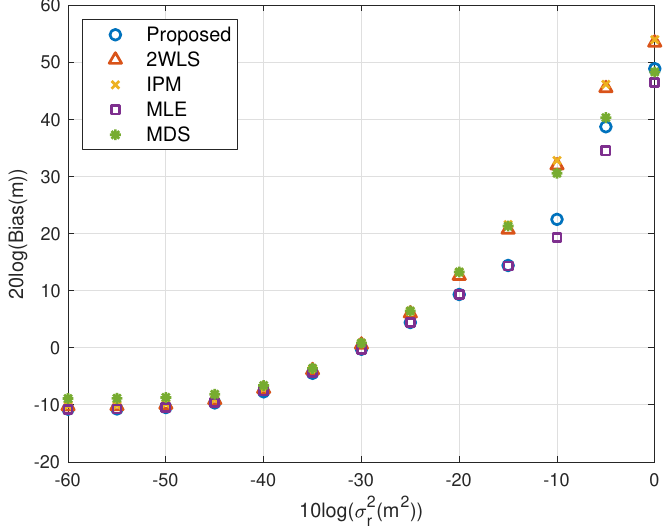
Figure 5. Bias performance as noise power increasing (far source, 4